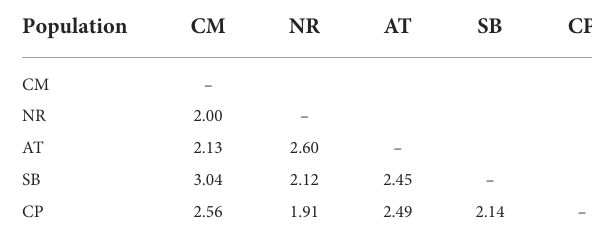
TABLE 4 Mahalanobis distances among the wing shape of Tabanus rubidus